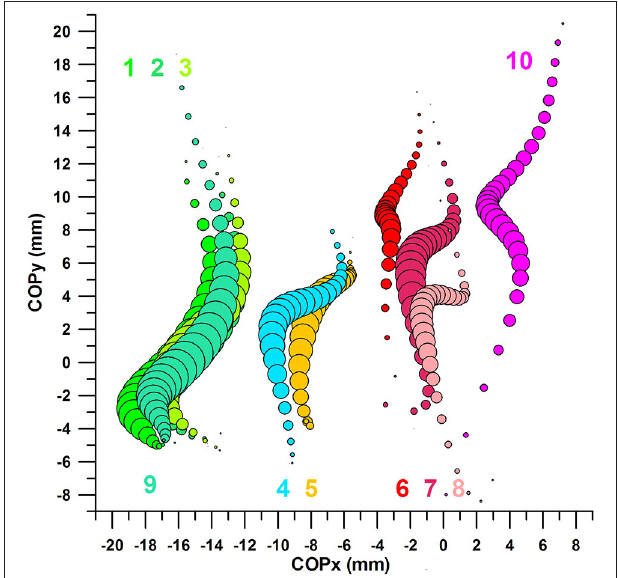
FIGURE 12 | Centre of pressure in y-direction (COPy) against Centre of pressure in x-direction (COPx); the bubble size of the 10 bubble plots corresponds to the impact force; the graphs are aligned to the coordinate system of the sensor matrix: positive COPy data = distal; negative COPy data = proximal; negative COPx data = medial; positive COPx data = lateral; 1–8: cf. legend of Figure 11 ; 9: average COP of successful kicks, COPx, COPy, and Fmax within the favorable ranges; 10: average COP of successful kicks, COPx, COPy, and Fmax within the un favorable